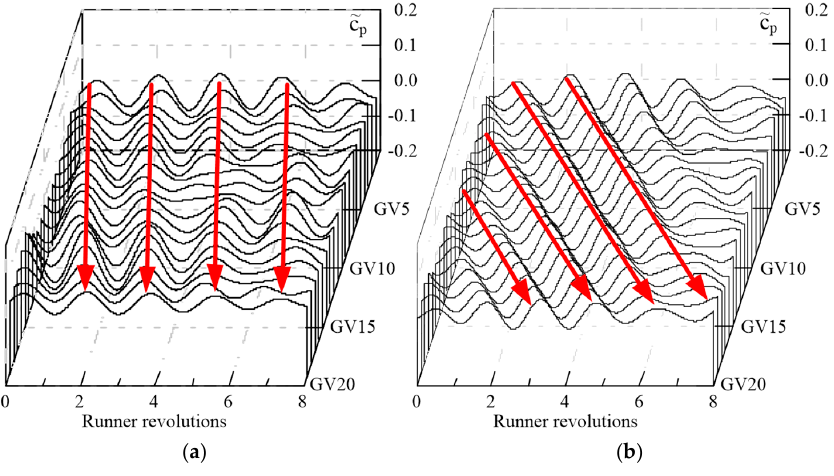
Figure 12. Propagation of rotating stall. ( a ) Runaway point OP5; and ( b ) low-discharge point OP6.